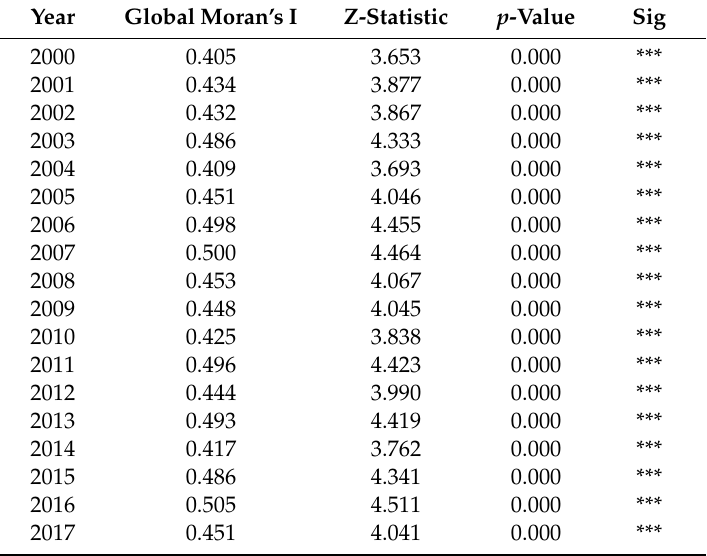
Figure 1. Spatial distribution characteristics of land urbanization and smog pollution in China. ( a ) Mean of ambient fine particulate matter (PM 2.5 ) concentration; ( b ) mean of land urbanization rate; ( c ) growth of PM 2.5 concentration; ( d ) growth of land urbanization rate. Table 3. Global Moran’s I of China’s PM 2.5 concentration,